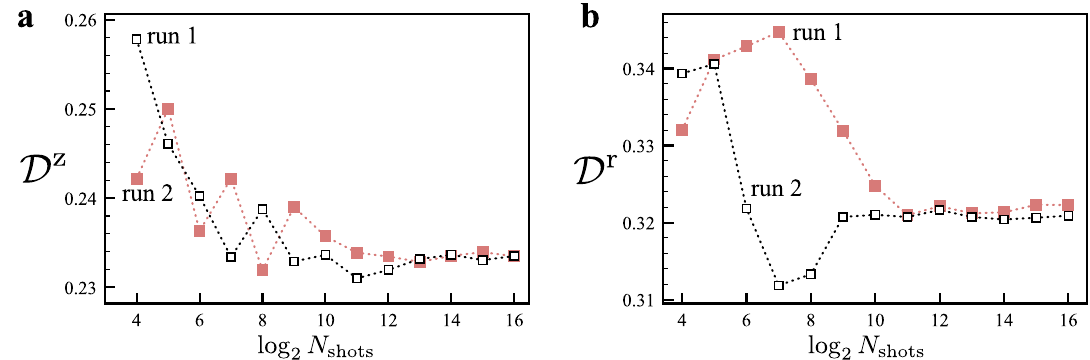
Fig. 11 Dissimilarity convergence as a function of the number of measurements. ( a ) and ( b ) represent dissimilarities obtained for σ z and random bases. N shots is number of measurements. The D = 8 16-spin Dicke state is considered. In each basis, two independent runs are